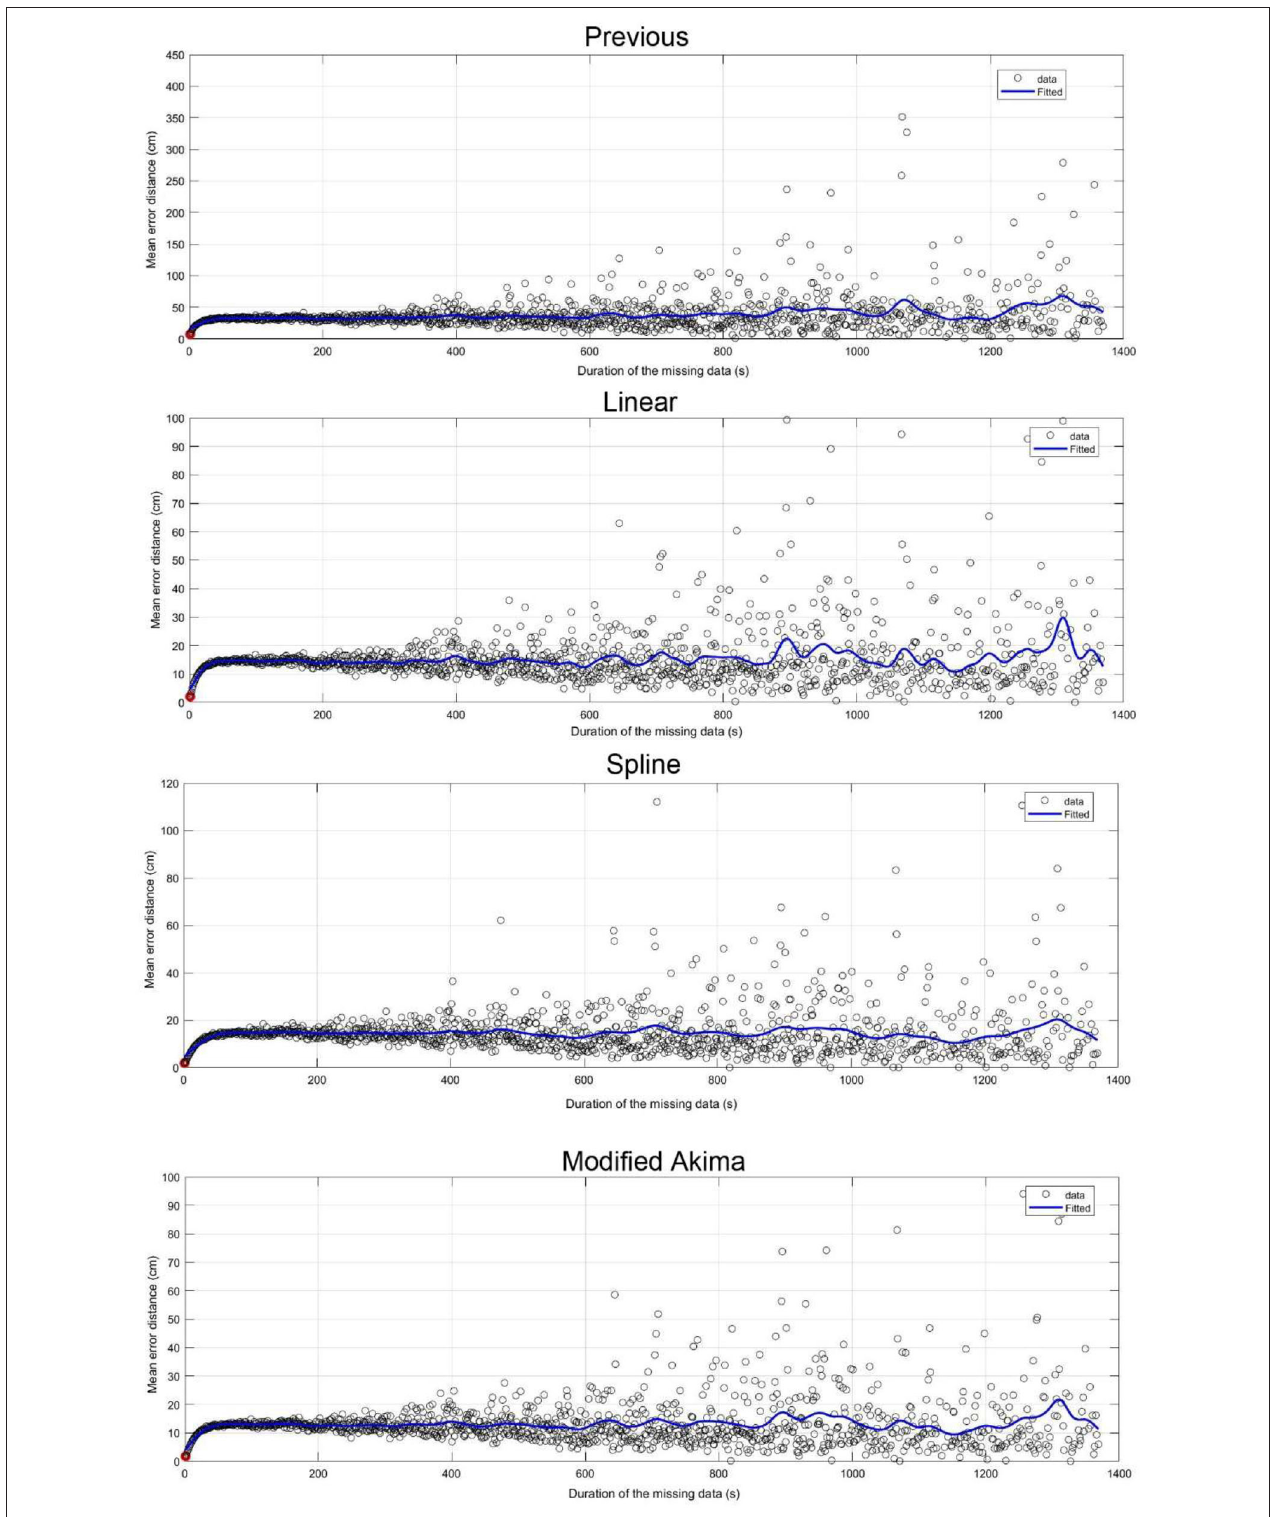
FIGURE 5 | Development of mean error distance with the four different interpolation methods. The data points “o” (blank dots) are the mean error distances related to the duration of the missing data. The smooth curves are spline curves fitted to the data points.